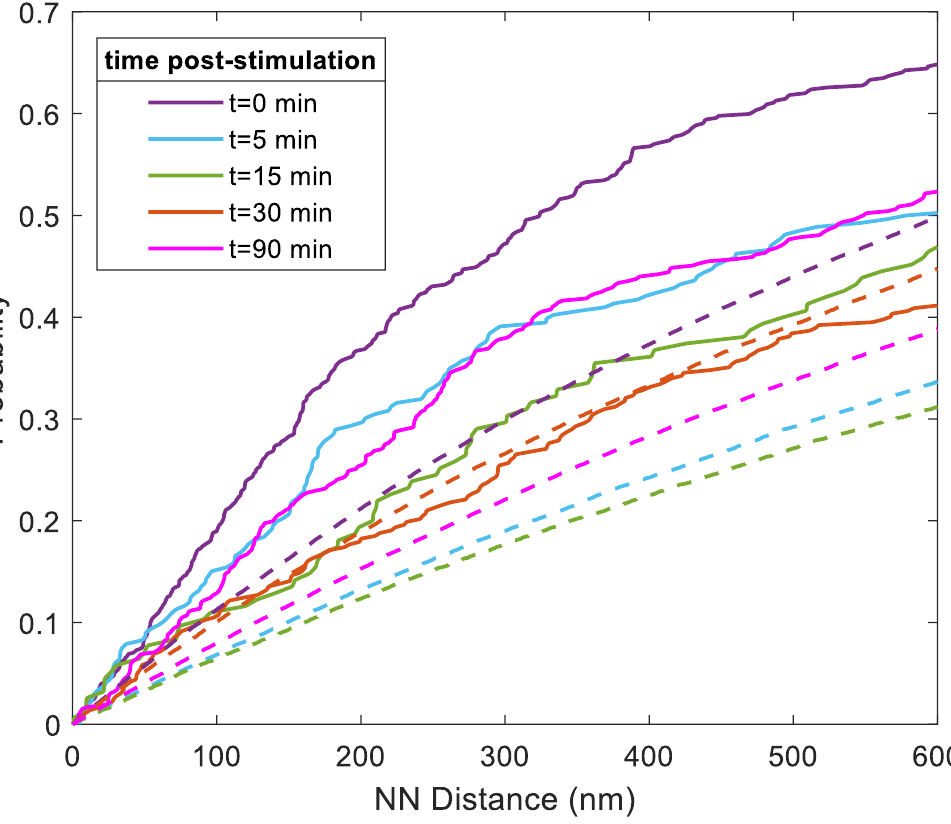
Figure 3. Cumulative distribution functions of the distance of each FLS2 to its nearest-neighbor remorin at increasing time points (see color key) post-ligand stimulation. Solid lines indicate exper- imentally observed values. Dashed lines indicate simulated random distribution values. Measure- ments for nearest-neighbor distances were performed up to 40,000 nm (Figure S5), while this figure details length scales relevant to nanodomains.